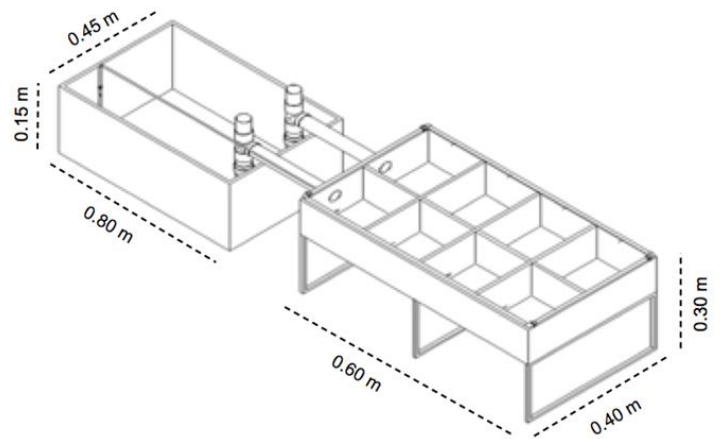
Figure 1. Recirculated Modular System (RMS). Each module is divided into 8 compartments. Each compartment is supplied in parallel with filtered artificial seawater (ASW) through one individual inlet pipe, derived from the main inlet pipe manifold system.